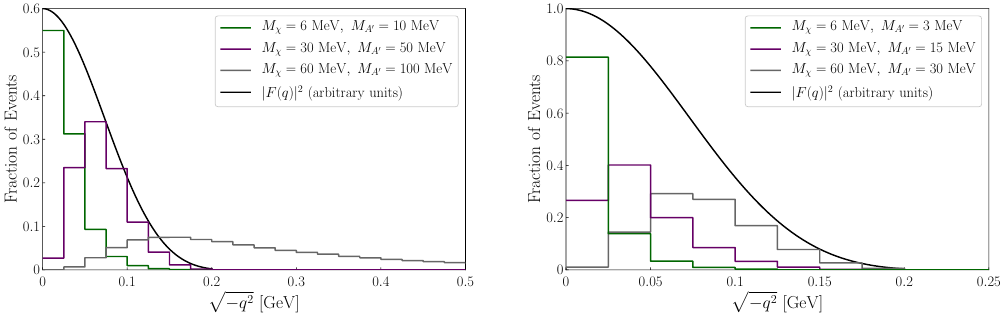
Figure 5 . The distribution of the momentum transfer to the argon nucleus for six dark matter and dark photon mass combinations. The dark matter to dark photon mass ratio is set to 0 : 6 (2) in the left (right) plot. The black curves in the same plots show the Helm form factor F ( q 2 ). In the left plot F ( q 2 ) has been scaled by 0 : 6 for